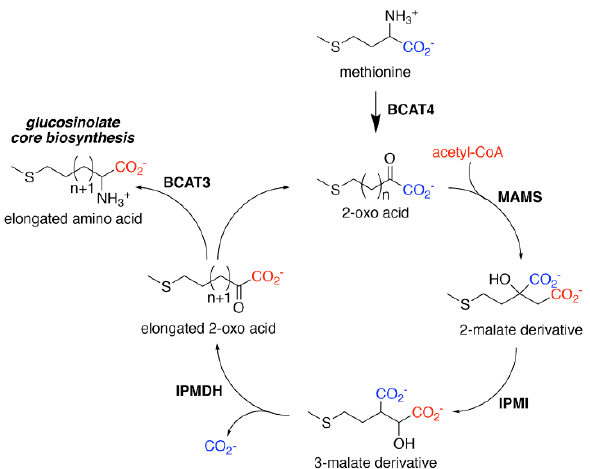
Figure 2. Aliphatic Glucosinolate Chain Elongation. Conversion of methionine to its corresponding 2-oxo acid (4–(methylsulfanyl)–2–oxobutanoate) by branched-chain amino transferase 4 (BCAT4) provides the starting point for the chain elongation cycle. A series of reactions catalyzed by methylthioalkylmalate synthase (MAMS), isopropylmalate isomerase (IPMI), and isopropylmalate dehydrogenase (IPMDH) result in elongation of the aliphatic chain by a single methylene group. The elongated 2–oxo can undergo transamination to the corresponding amino acid by BCAT3 or reenter the chain elongation cycle.